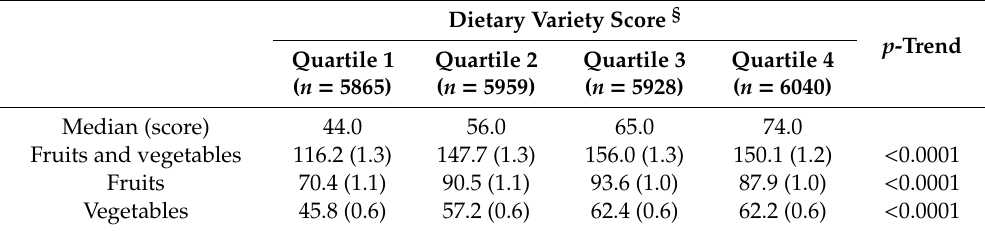
Table 4. Fruit and vegetable consumption according to quartile of dietary variety